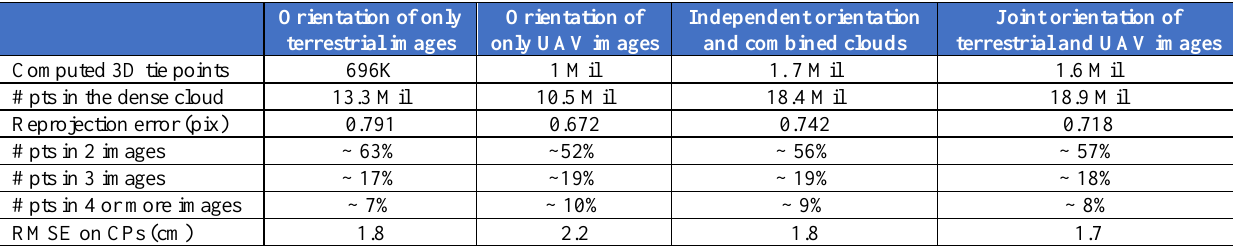
Table 1: Results of the orientation tests on the Cathedral images run with the independent and joint datasets. Number of reconstructed 3D points (sparse and dense clouds), reprojection error and multiplicity values with two different approaches: jointly-orientated and